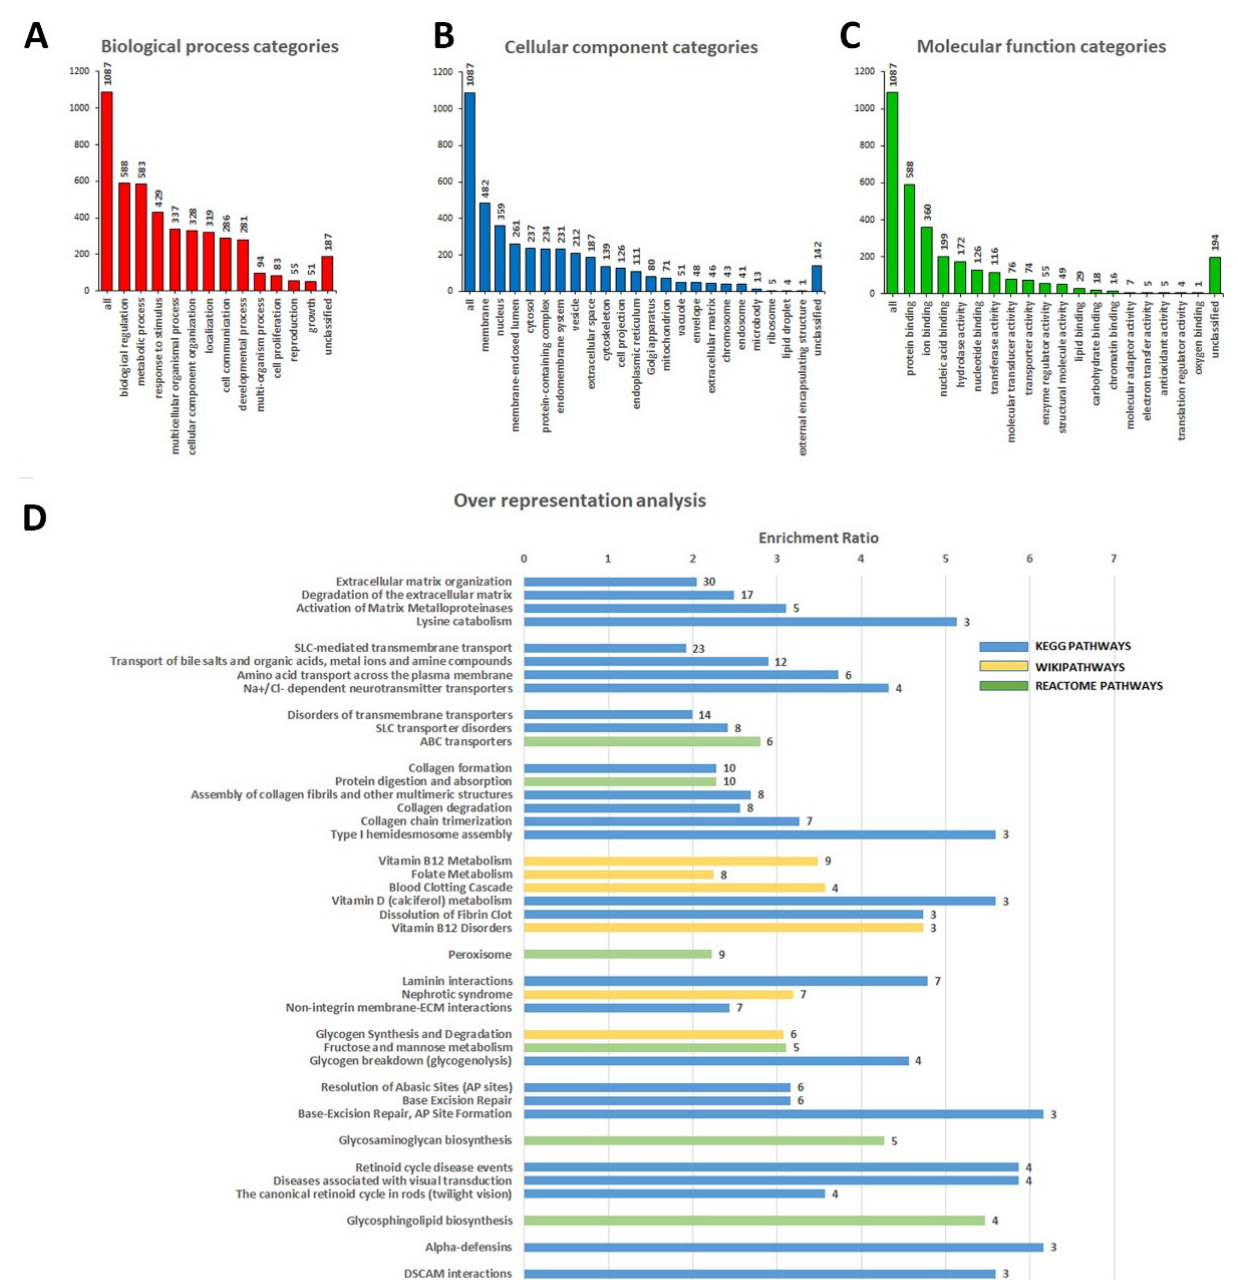
Figure 2. Over-representation analysis (ORA) made with Web-based Gene Set Analysis Toolkit (WebGestalt) using genes containing variants not previously associated with DCM. GO summary showing biological process ( A ), cellular component ( B ), and molecular function ( C ) categories in the red, blue, and green bars, respectively. The height of the bar represents the number of IDs in the user list and the GO category. ( D ) Bar chart of enrichment ratios for KEGG, Reactome, and Wikipathways categories. Enrichment ratio = the number of observed divided by the number of expected genes from each category in the gene list (according to the WebGestalt tool).